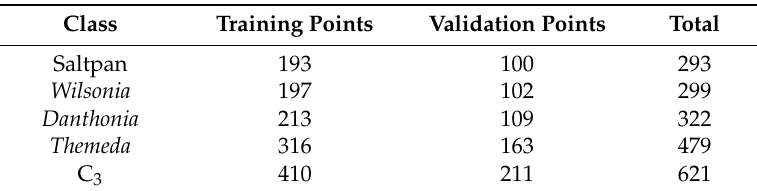
Table 1. Number of training and validation points used per class. Total point count is given in the final column. The C 3 class count is the sum of the Danthonia and Wilsonia counts.